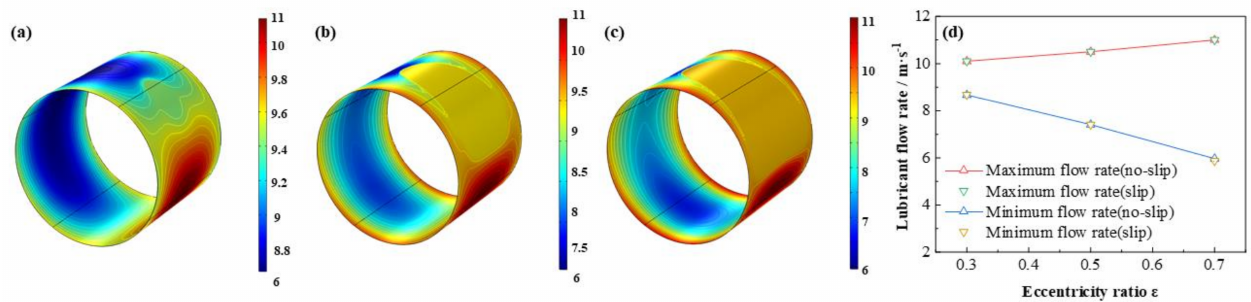
Figure 10. Comparison of the flow rate distribution under different eccentricity ratios. ( a ) ε = 0.3; ( b ) ε = 0.5; ( c ) ε = 0.7; ( d ) maximum/minimum flow